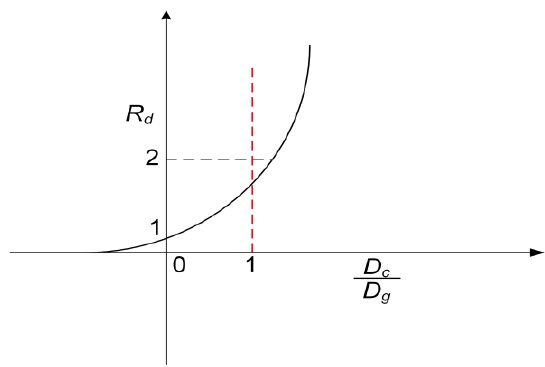
Figure 5. Linear direction illustration.